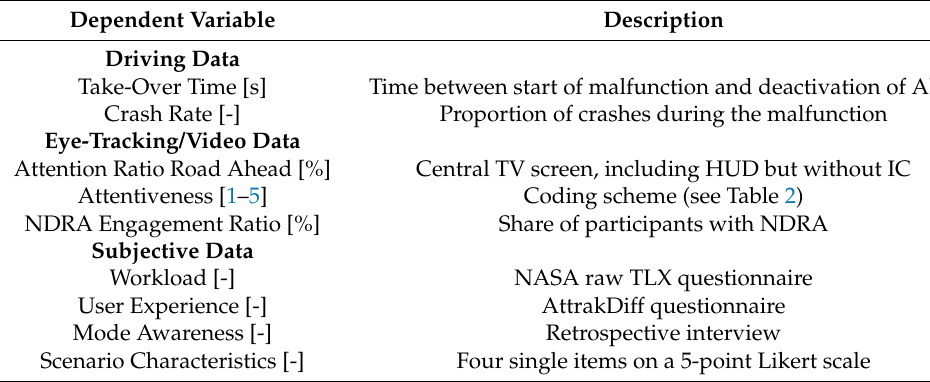
Table 1. Dependent variables and description.